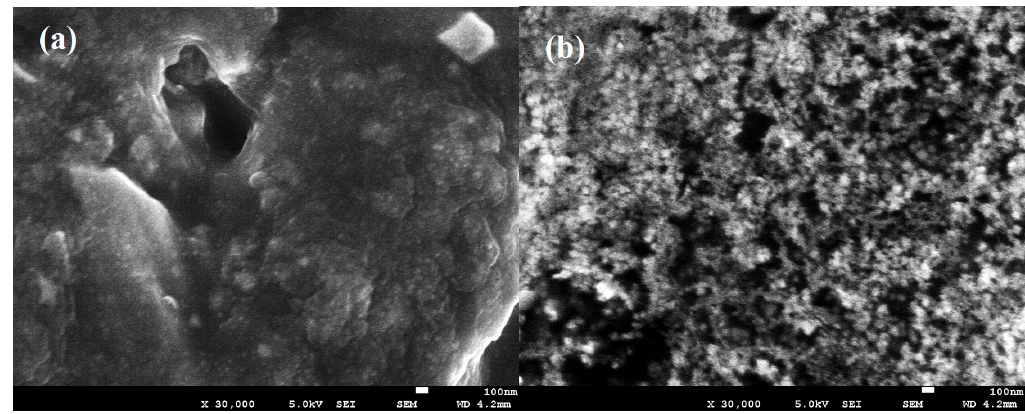
Figure 2. SEM images of ( a ) Ti 0 and ( b ) Ti 3.